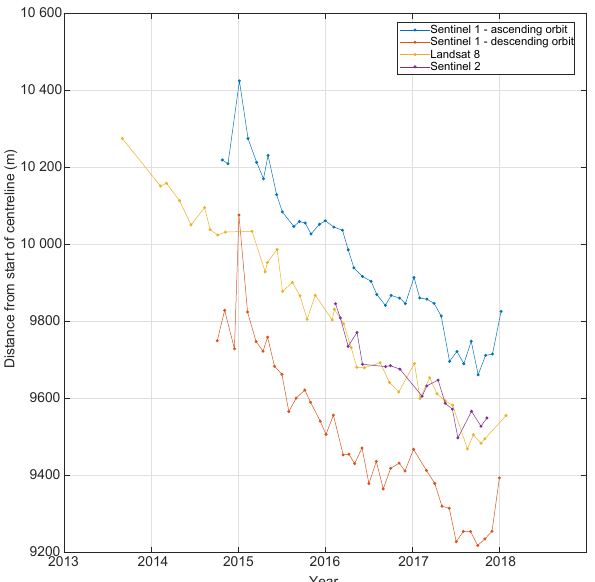
Figure 4. Intercomparison of results from different margin quantifi- cation methods applied to the Landsat 8 monthly record of margin positions at